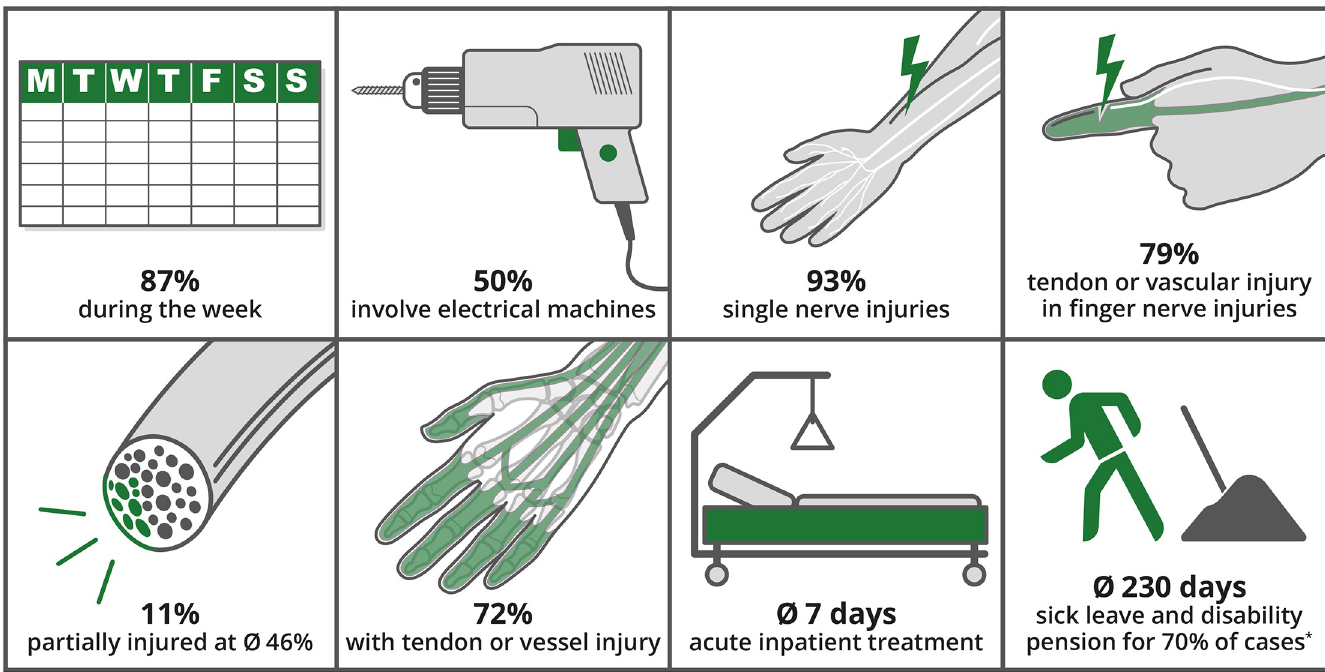
Fig 2. Injury characteristics: Schematic illustrations of the main injury characteristics of the involved patient population.